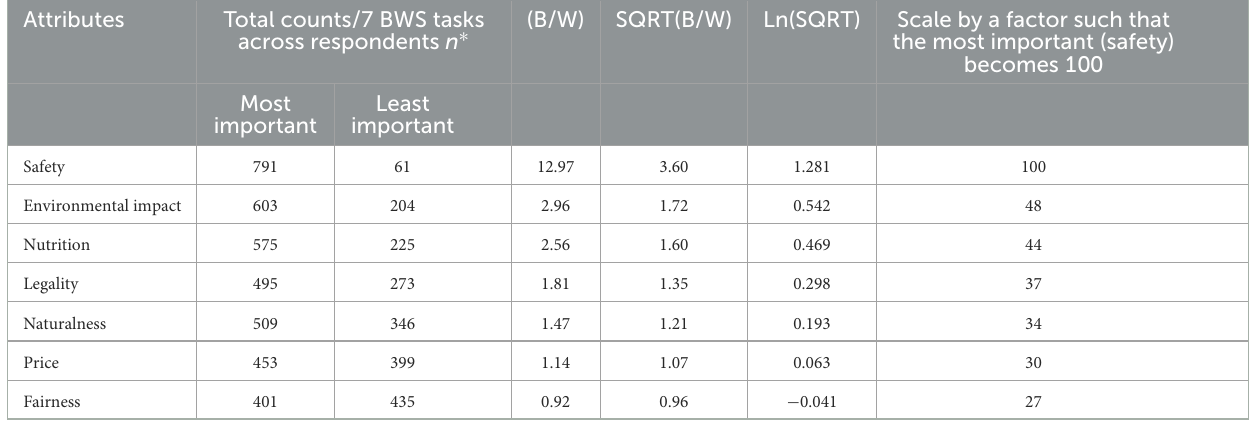
TABLE 4 Descriptive statistics for the sample. Attributes